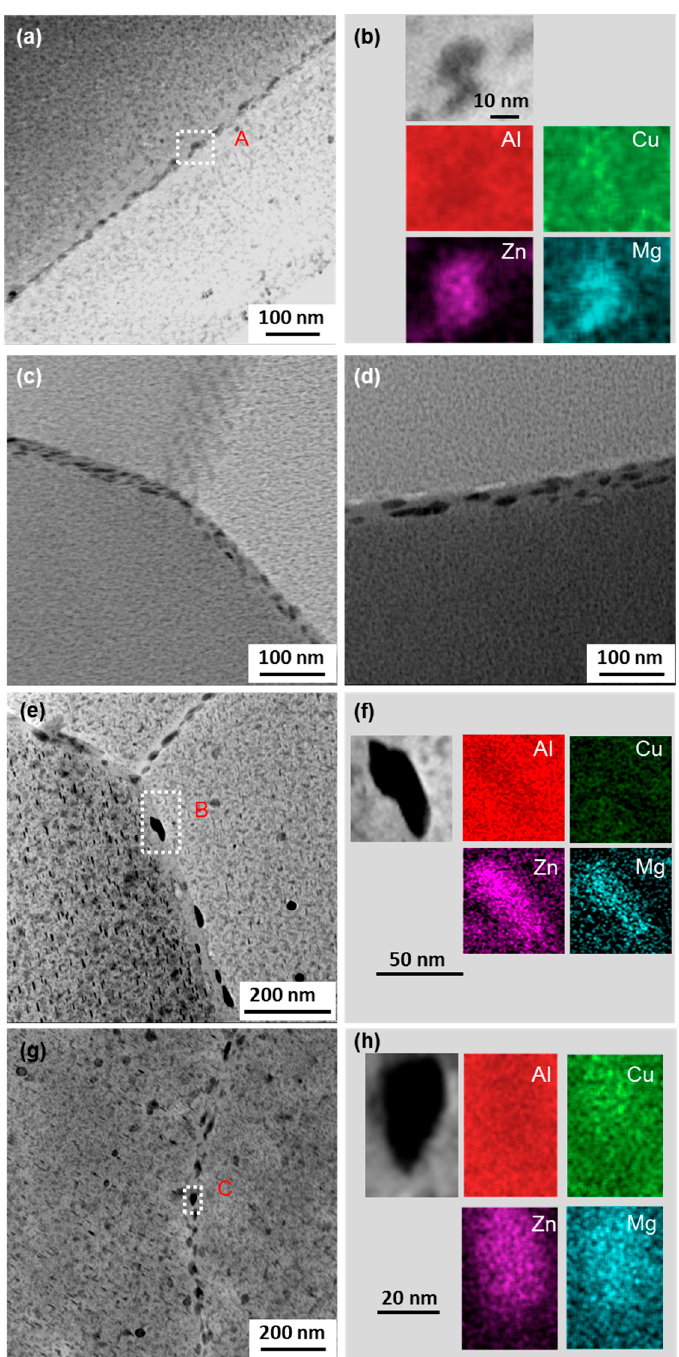
Figure 5. The precipitates distributed along the grain boundaries and elemental mapping of Al, Cu, Zn and Mg in grain boundary phase at different aging treatment of the experimental alloys: ( a , b ) Ce-free alloy at T6 temper; ( c , d ) Ce-containing alloy at T6 temper; ( e , f ) Ce-containing alloy at T7 temper; ( g , h ) Ce-containing alloy at RRA temper.